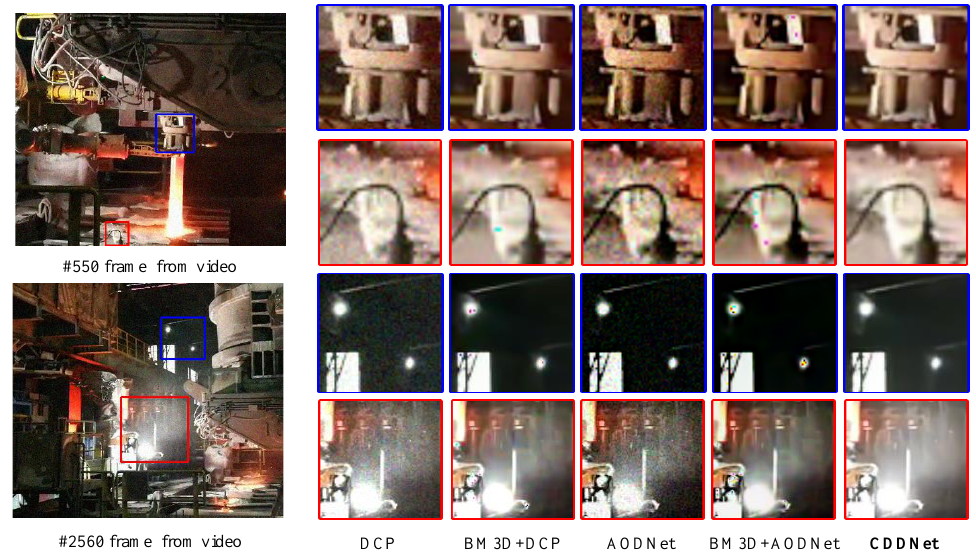
Figure 5. Hazy and noisy frames from a video. CDDNet retained fine details and kept the colors